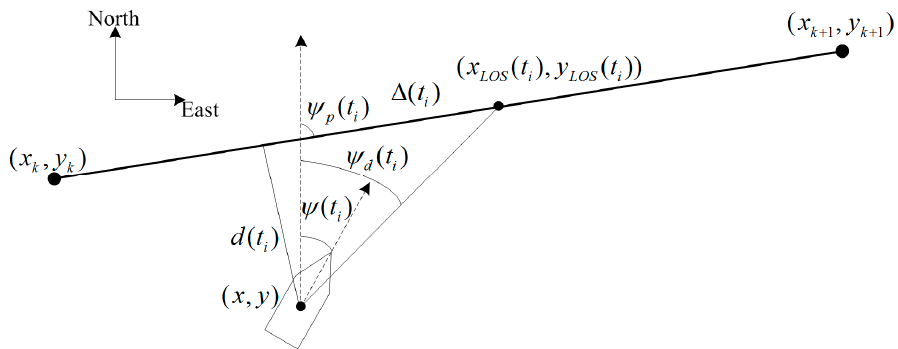
Figure 12. The principle of the LOS guidance algorithm.